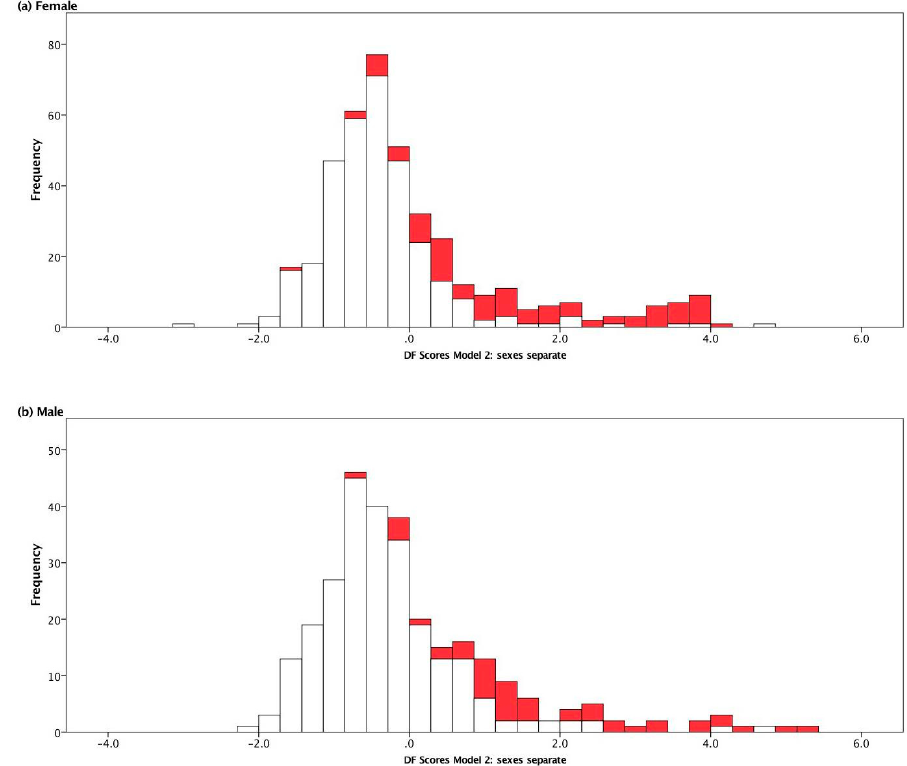
Figure A1. Histogram of scores from Model 2 discriminant functions analysis, for ( a ) females and ( b ) males. Solid bars: Type 2 diabetes mellitus (T2DM) participants; open bars: Non-T2DM participants.